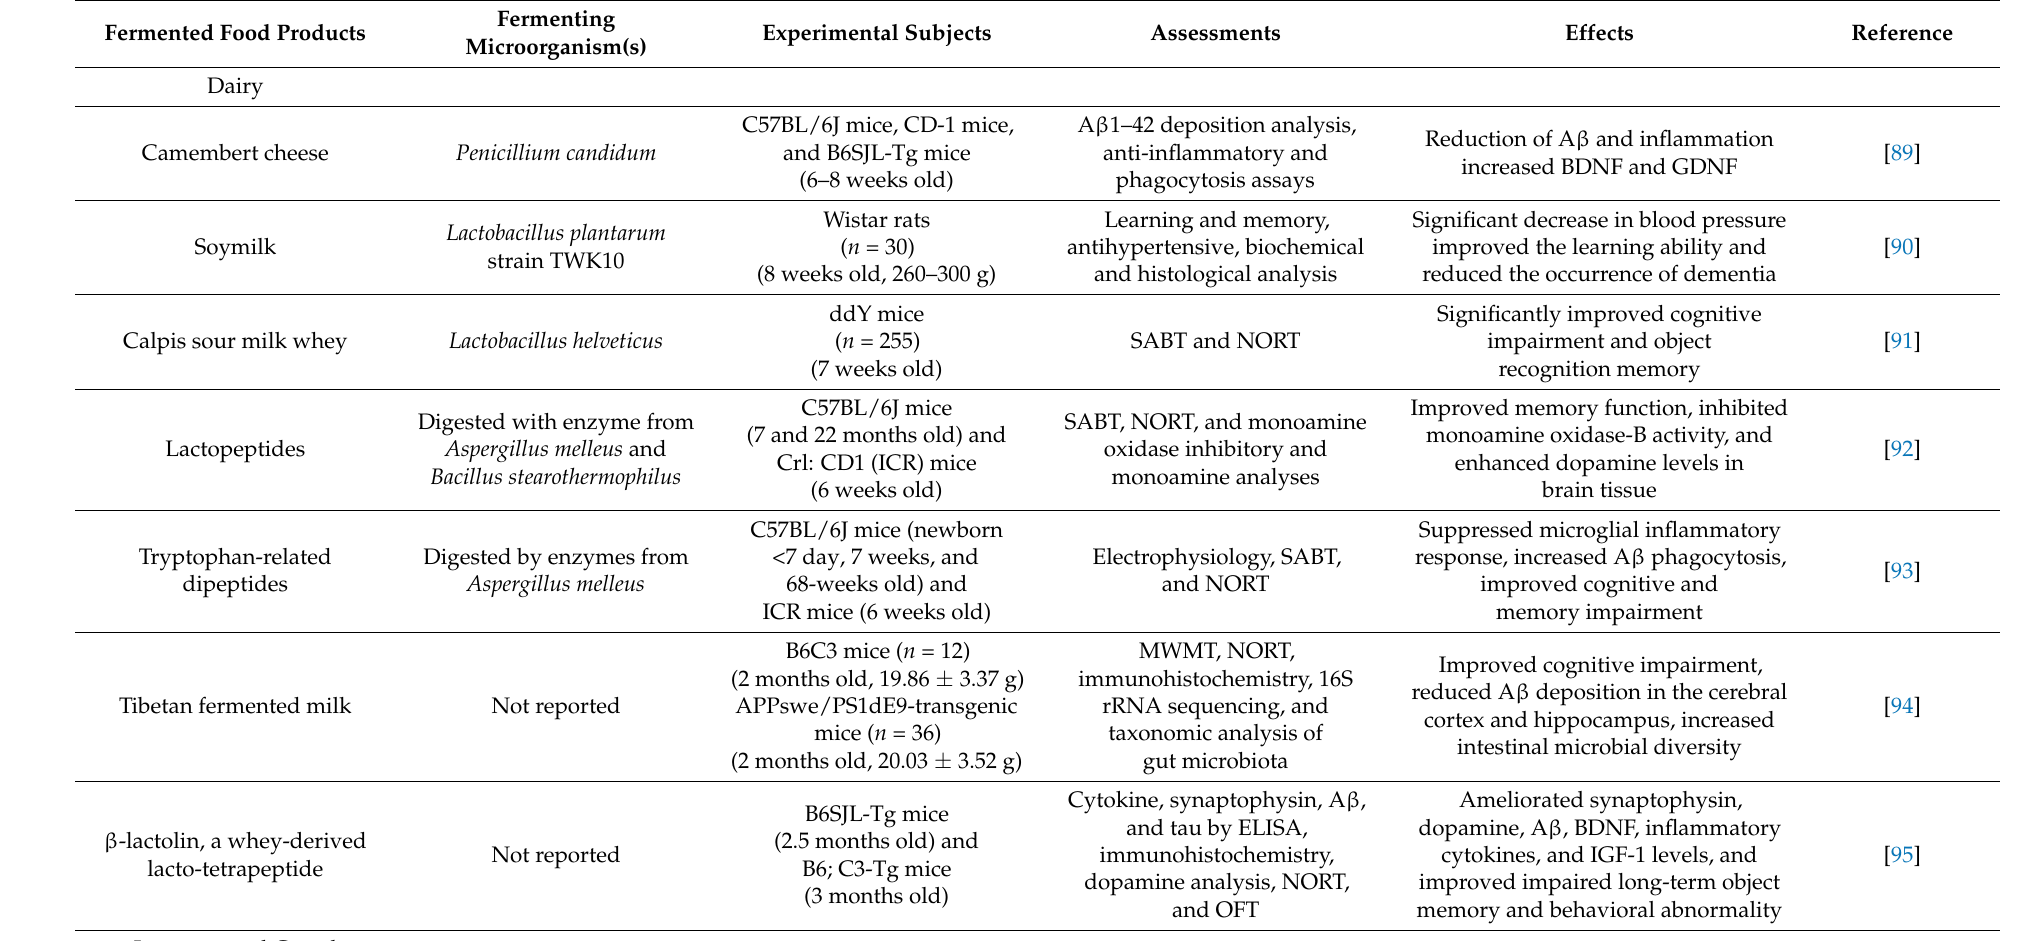
Table 3. Preclinical in vivo studies of fermented foods and their effects on